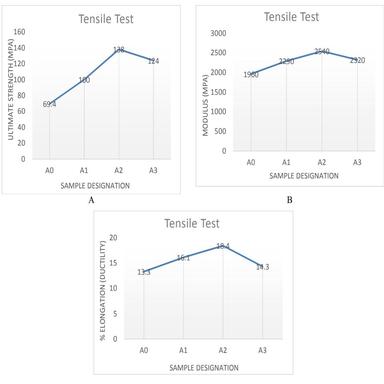
Graphical representation of the tensile test of the Al-4032 based metal matrix composites (a) Ultimate strength MPa (B) Modulus MPa (c) Percentage elongation